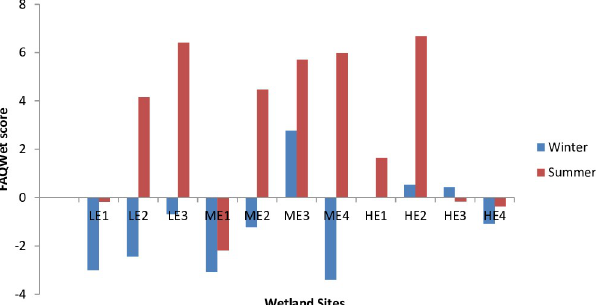
Fig 4. FAQWet scores recorded in each of the selected wetland sites and seasons. (LE 1–3 = Less Eroded, ME1– 4 = Moderately Eroded, HE1–4 = Highly Eroded)